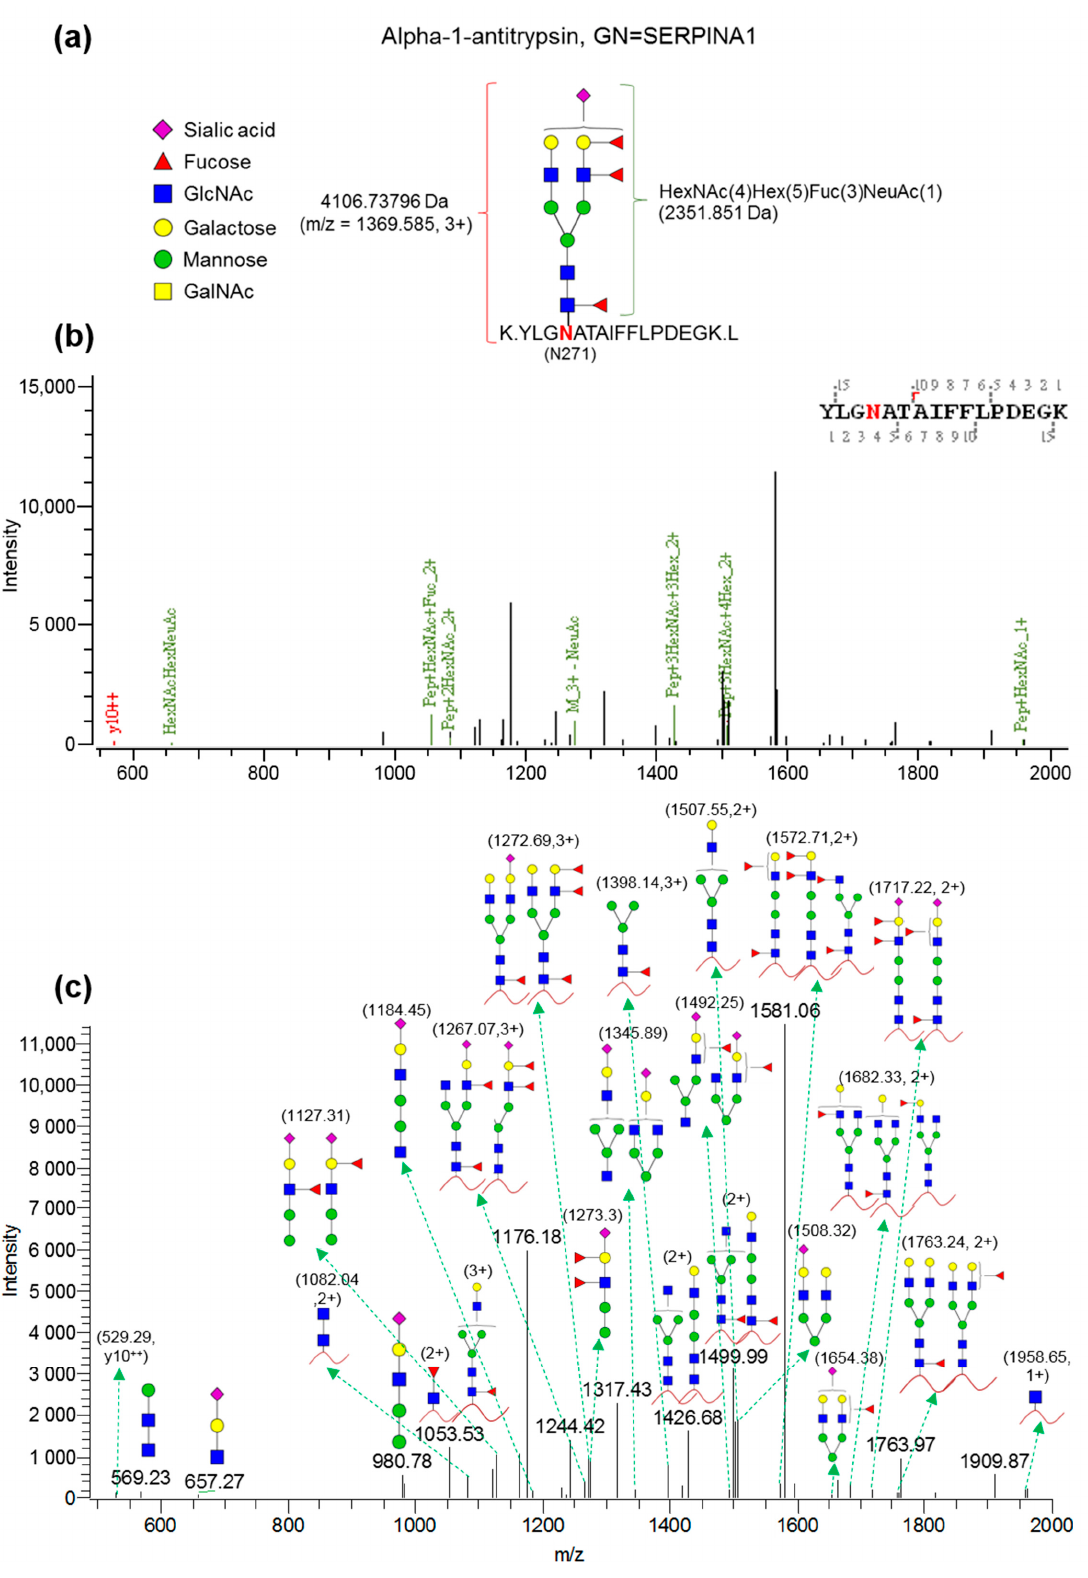
Figure 3. Analysis of the glycan structure of SERPINA1 (YLGNATAIFFLPDEGK). ( a ) The glycan structure of the target glycopeptide, YLGNATAIFFLPDEGK, identified in SERPINA1, was deciphered using Byonic software. ( b ) MS/MS spectrum of the targeted glycopeptide was analyzed and annotated using Byonic software. ( c ) Structures of glycan and glycopeptide were manually annotated in the MS/MS (CID) spectrum based on Byonic analysis.